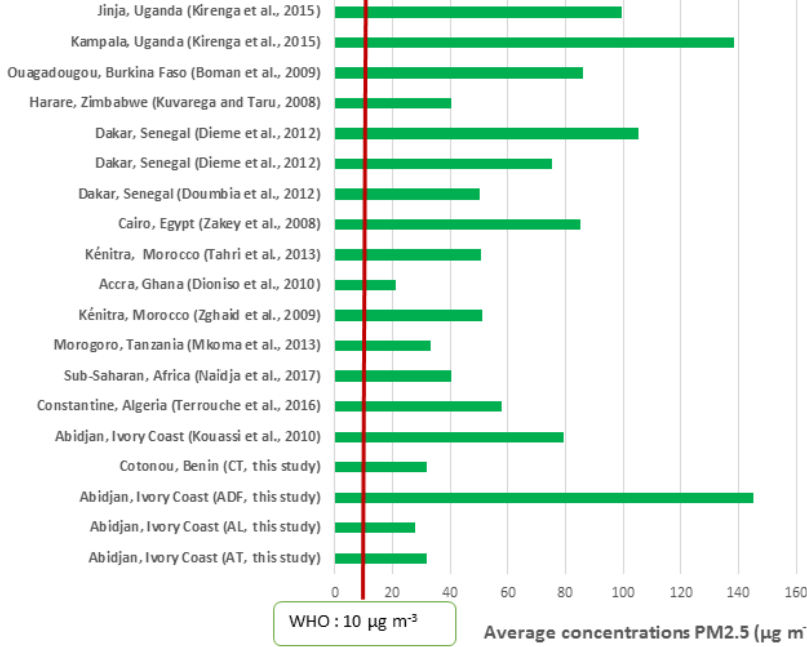
Figure 9. Comparison of PM 2 . 5 mass concentrations at the four sites with those in other African cities. Red vertical line illustrates current WHO